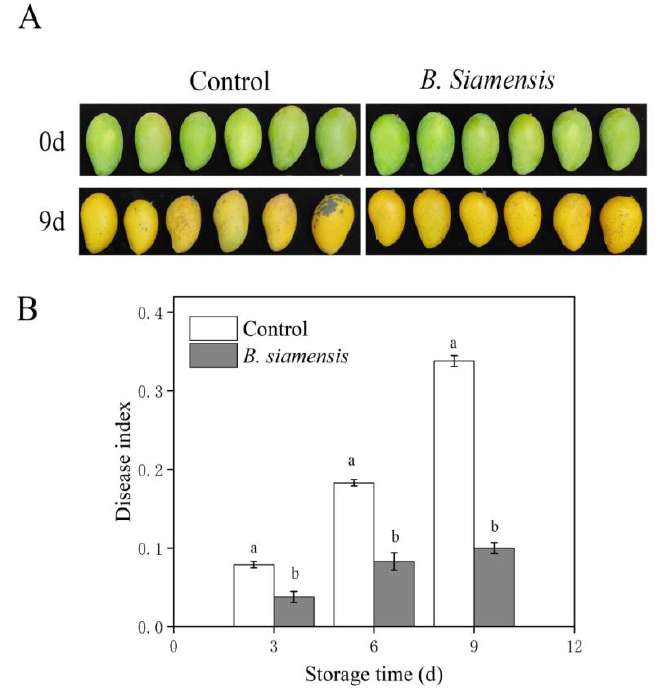
Figure 1. Effect of B. siamensis treatment on appearance and anthracnose symptoms ( A ) and disease index ( B ) of mango fruit stored at 25 °C for 9 days. Bars with different lowercase letters indicate significant differences based on a t-test at the p ≤ 0.05 level. Each value represents the mean ± SE of three replicates.